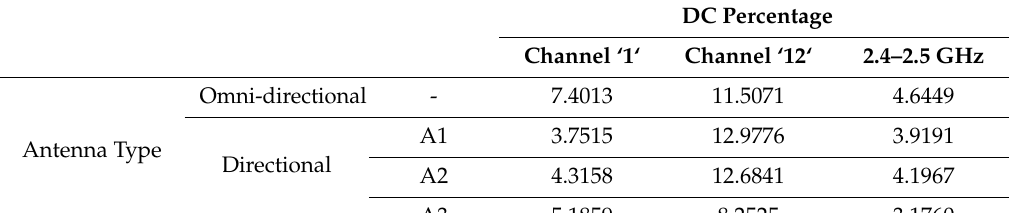
Table 6. Summary of DC percentages in relation to omni and directional antennae.